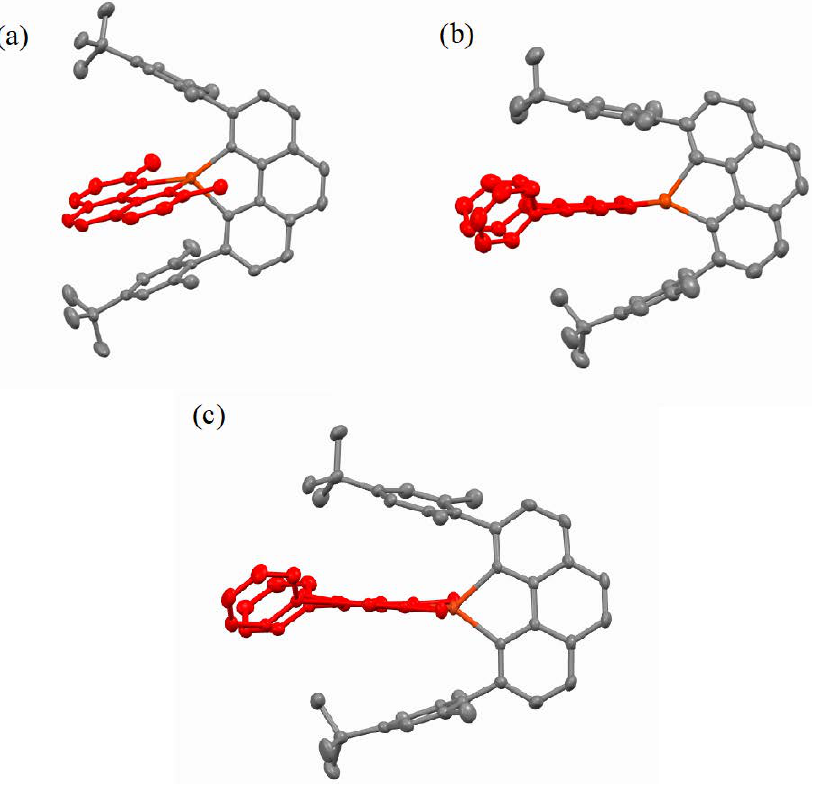
Figure 2. X-ray crystal structures of C2 ( a ), C3 ( b ) and C4 ( c ). Hydrogen atoms omitted for clarity.